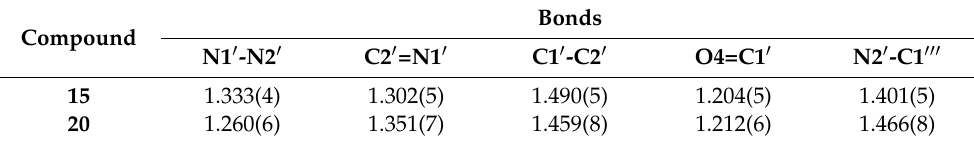
Table 3. The bond lengths (Å) of O4=C1 (cid:48) C2 (cid:48) =N1 (cid:48) N2 (cid:48) C1 (cid:48)(cid:48)(cid:48) moiety for isomers 15 and 20 . Compound